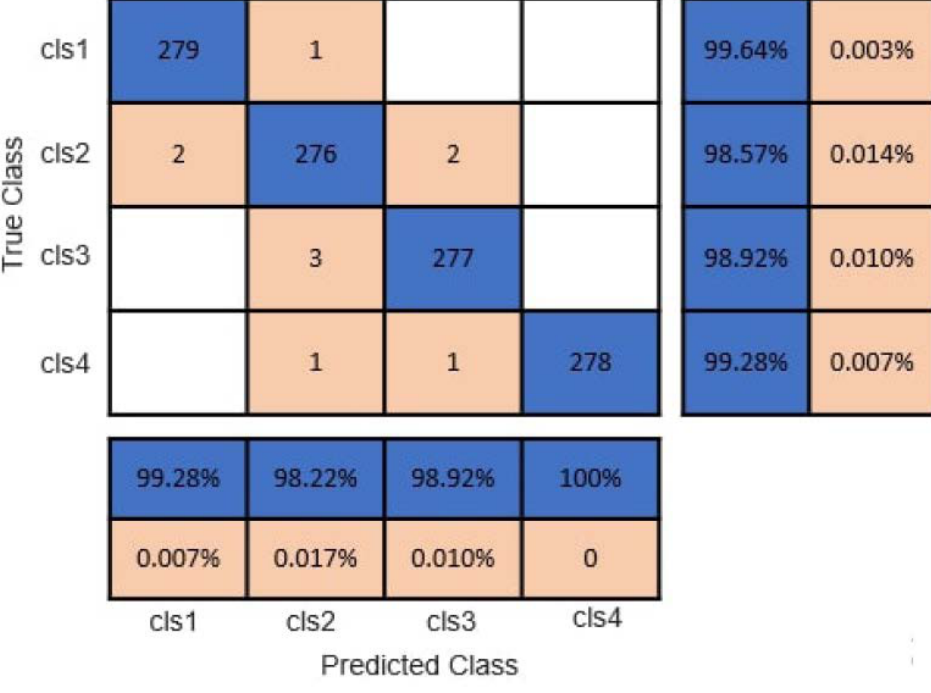
Figure 56. Confusion matrix plots and their accuracies for prediction of bearing fault size using a convolutional neural network with continuous wavelet transform [141].